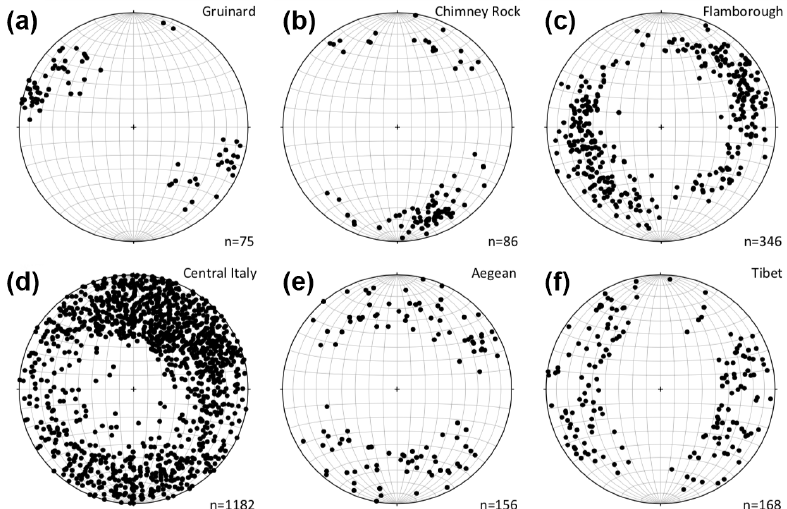
Figure 5. Stereographic projections (equal area, lower hemisphere) showing the six natural datasets used in this study. All plots show poles to faults, the majority of which are inferred to be normal. (a) Data from deformation bands measured in faulted Triassic sandstones at Gruinard Bay, Scotland (Healy et al., 2006a, b). (b) Data from faults and measured in sandstones at Chimney Rock in the San Rafael Swell, Utah, USA. Data digitised from Krantz (1989). (c) Data from faults measured in cliffs of Cretaceous chalk at Flamborough Head, NE England. Data digitised from Peacock and Sanderson (1992). (d) Data from faults measured in the Apennines of central Italy. Data digitised from Roberts (2007). (e) Data from focal mechanism nodal planes derived from the CMT catalogue for the Aegean region (Ekström et al., 2012). (f) Data from focal mechanism nodal planes derived from the CMT catalogue for the Tibet region (Ekström et al., 2012).